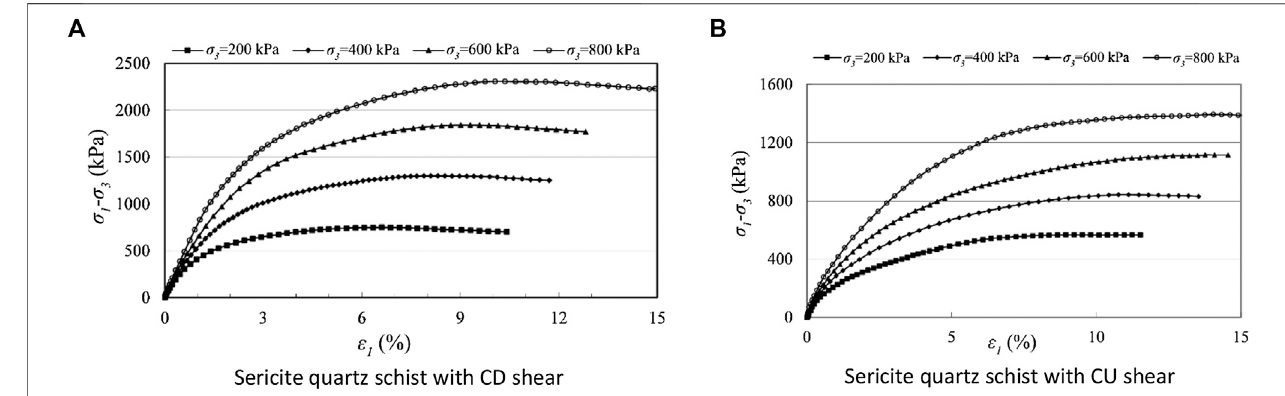
FIGURE 5 | Stress-strain curves of saturated samples under different con fi ning